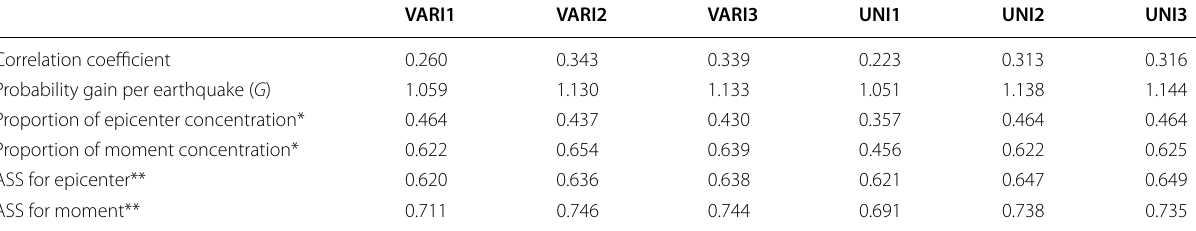
6 crustal earthquakes ≥